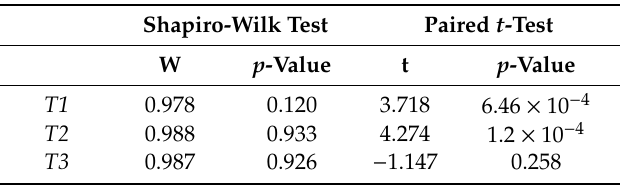
Table 3. Results from the Shapiro-Wilk test performed on the computed time differences, and from the t-test performed on the paired time samples, for each task considered in the in-lab usability study.